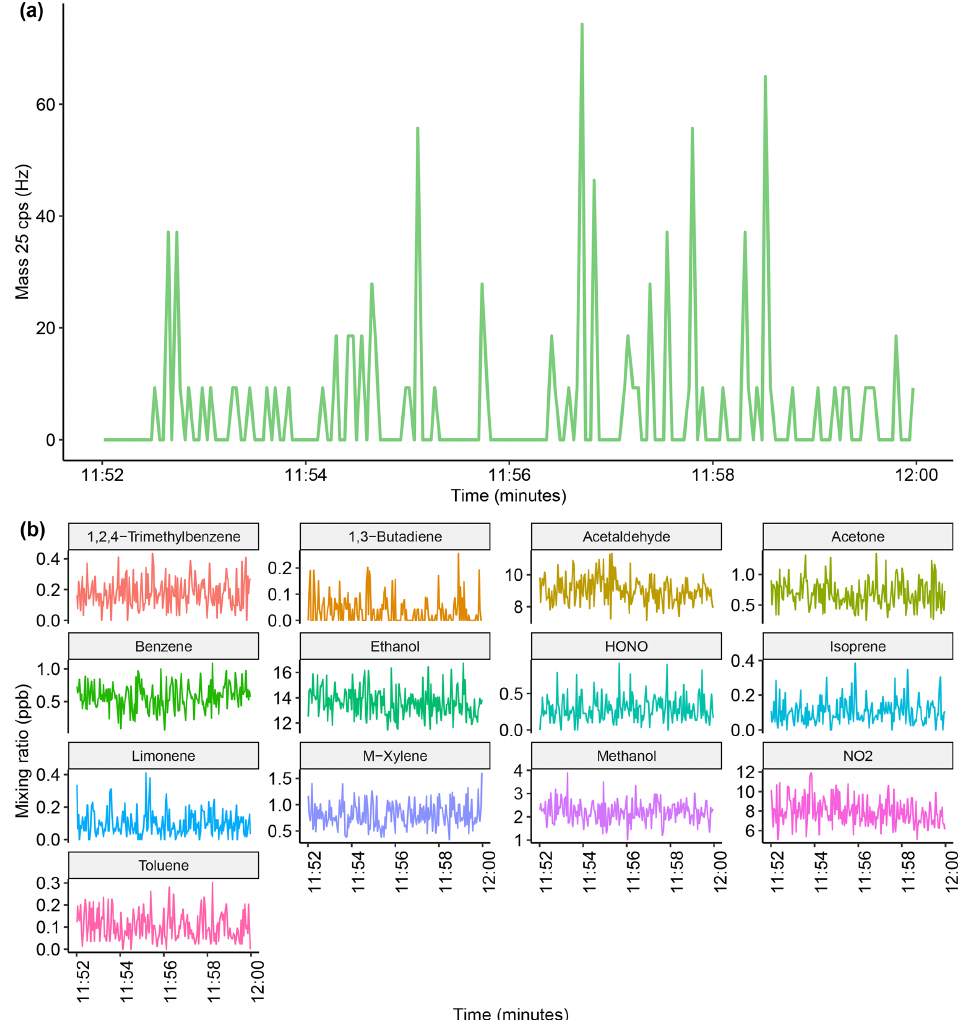
Figure A2. (a) Counts per second of mass 25, which represents instrument noise, and (b) mixing ratios of the compounds during a nitrogen- only mobile measurement.